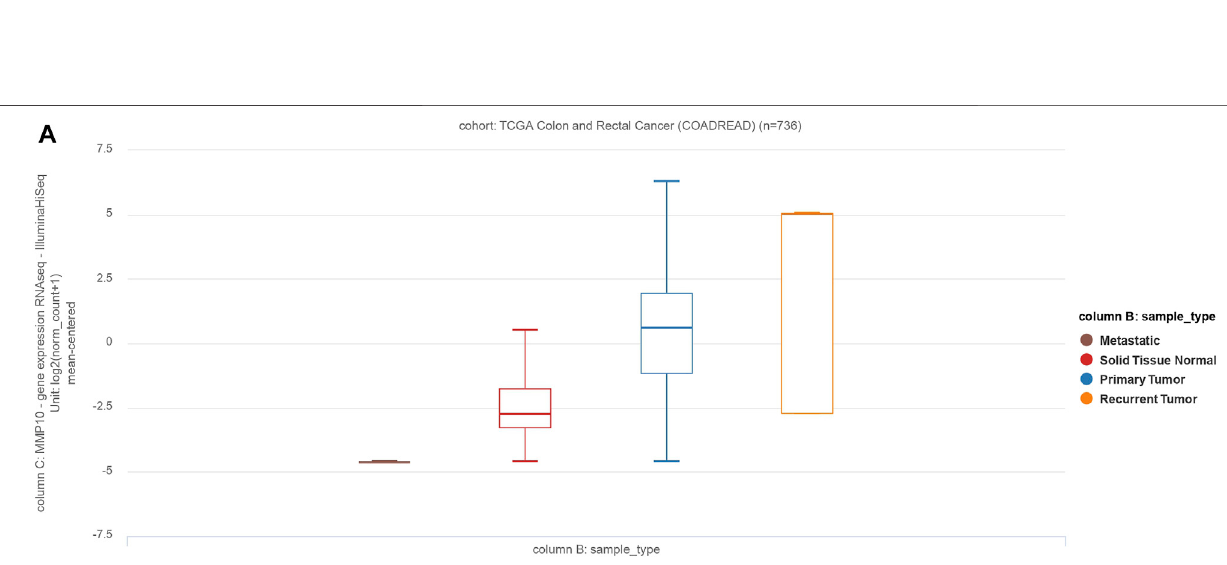
Frontiers in Genetics |